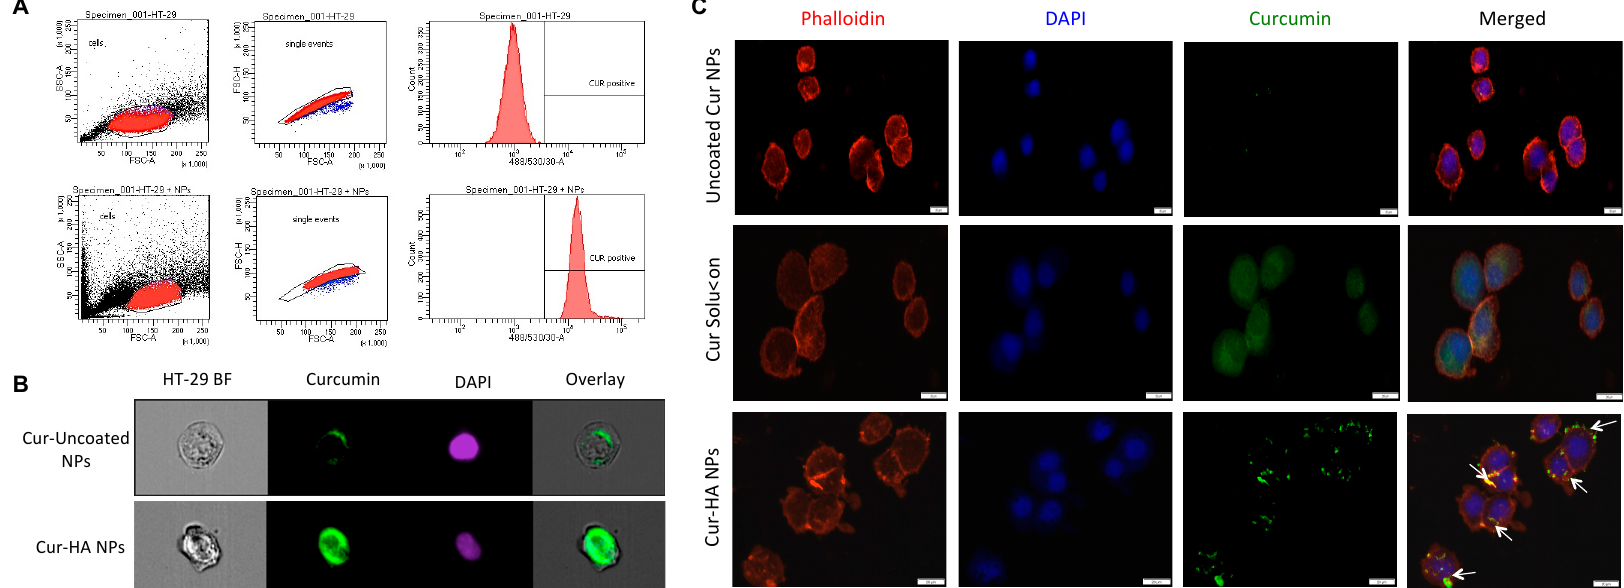
Figure 5. Hyaluronan functionalization increases the nanoparticles interaction, uptake in HT-29 cells. Flow cytometry histogram shows alone HT-29 cells, HT-29 cells treated with Cur-HA-NPs signal after 3 h incubation ( A ). Representative ImageStream flow cytometry images show HA functionalized particles has effective uptake in HA-29 cells ( B ). Representative slide scanner images of uncoated Cur NPs, Cur solution and Cur-HA NPs after 3 h incubation, HA functionalized NPs showing more cellular interactions and uptake compared to uncoated NPs; nuclei (blue) stained with DAPI, cytoskeleton (red) stained with rhodamine-phalloidin, curcumin (green) ( C ).